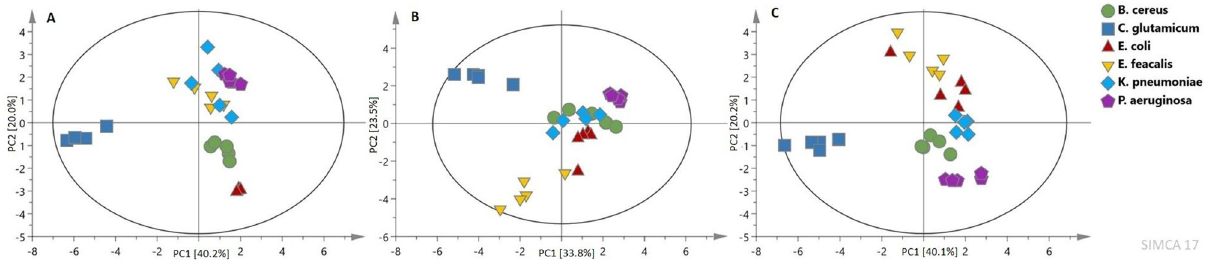
Figure 4. PCA score plots for each one disintegration method for all strains: ( A ) sonication, ( B ) sand mill, ( C ) tissue lyser.